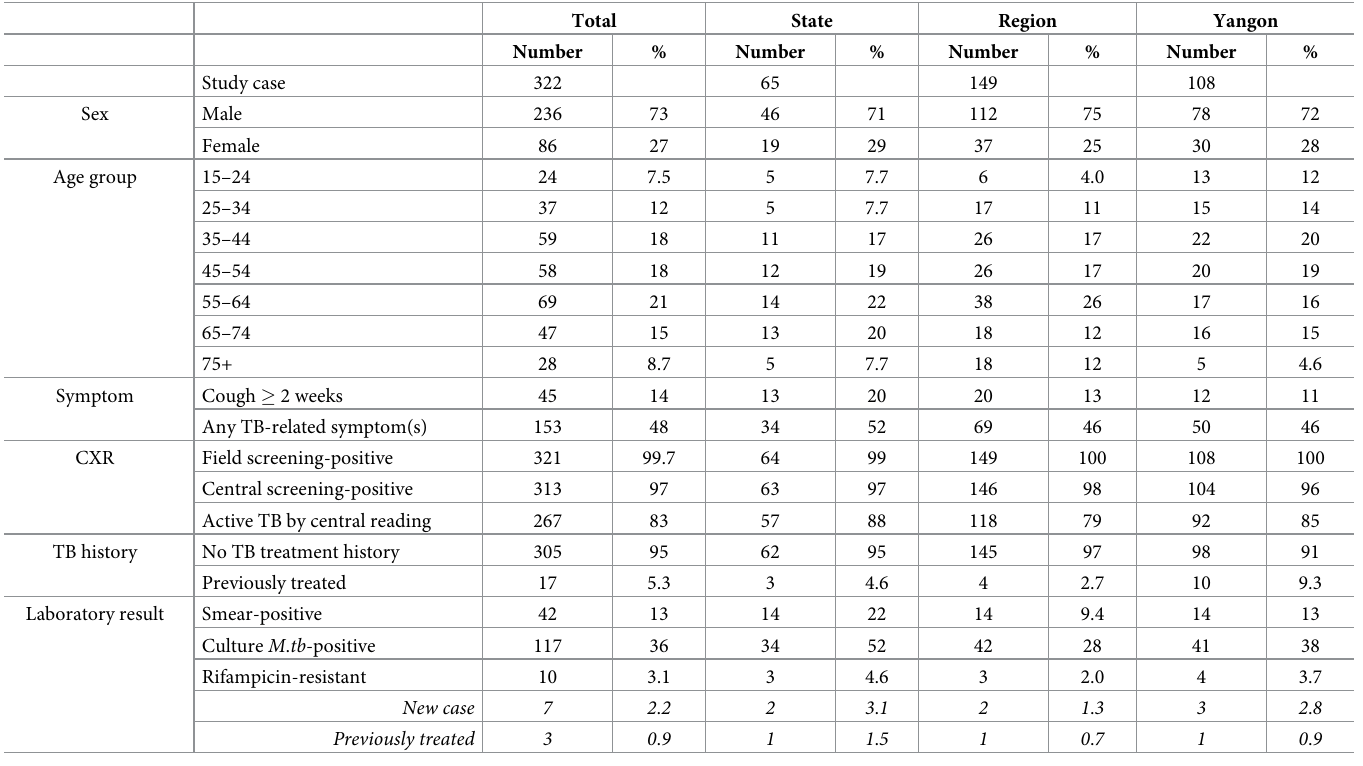
Table 3. Characteristics of study TB